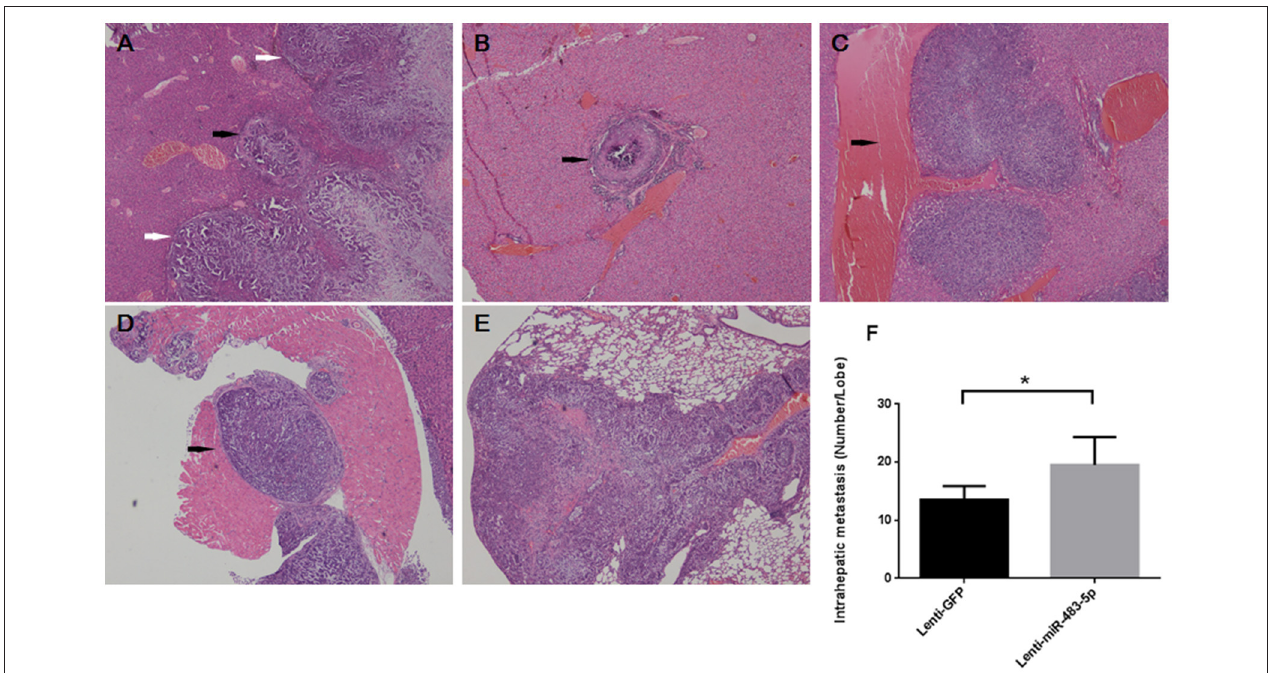
FIGURE 3 | miR-483-5p promotes HCC cell invasion and metastasis in vivo , (A–F) showed intrahepatic metastasis and distant metastasis (lung) in Lenti-miR-483-5p mice. (A) Orthotopic primary liver tumor (white arrows) and intrahepatic metastatic nodules close beside tumor (black arrow). (B) Distant microvascular invasion in another liver lobe (black arrow). (C) Intrahepatic metastatic nodules close beside larger vein branch (black arrow). (D) Metastatic nodules invasion smooth muscular tissue near liver (black arrow). (E) Distant metastasis in the lung. (F) The numbers of metastatic nodules in the livers of each mouse are counted; the statistical significance is labeled using the 2 test. * p < 0.05, HE stained ×